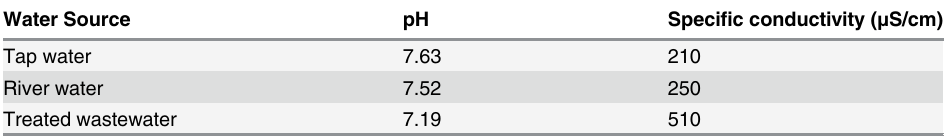
Table 1. Basic water quality parameters for the three water sources used in this study.